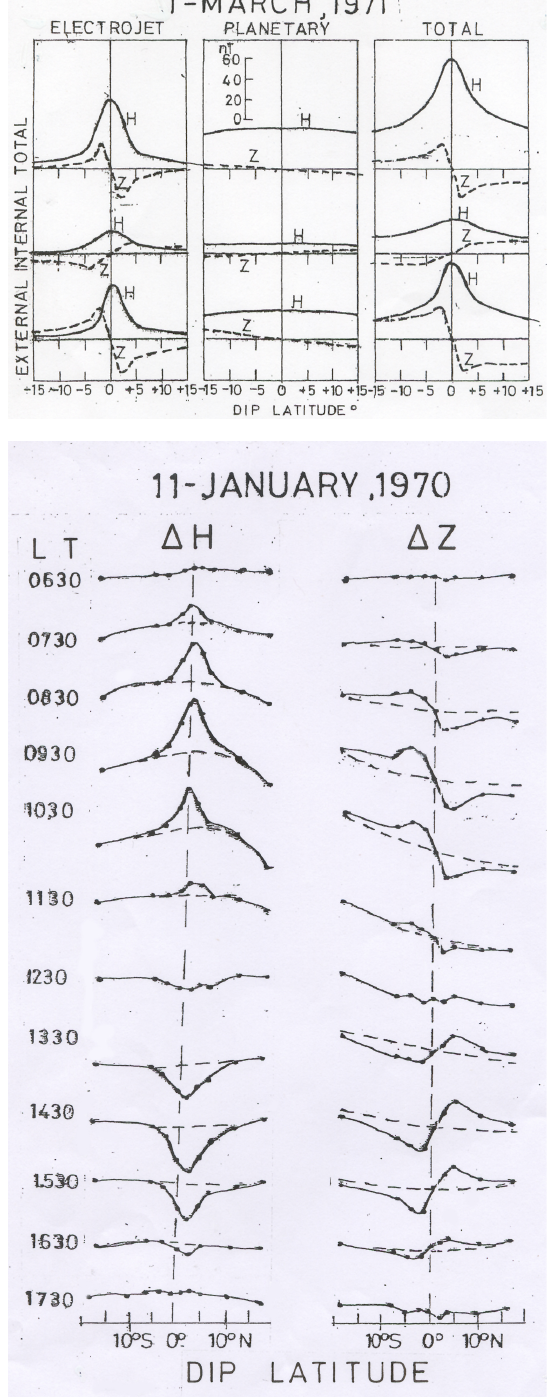
Fig. 1. (a) Latitudinal variations of the total planetary and elec- trojet components of 1H and 1Z due to the ionospheric current (external) and the induced current inside the Earth’s core (internal) at a network of geomagnetic stations in Ethiopia (after Carlo et al., 1982). (b) Latitudinal variations of 1H and 1Z at stations across the magnetic equator in Central African region on 11 January 1970 (after Fambitakoye,